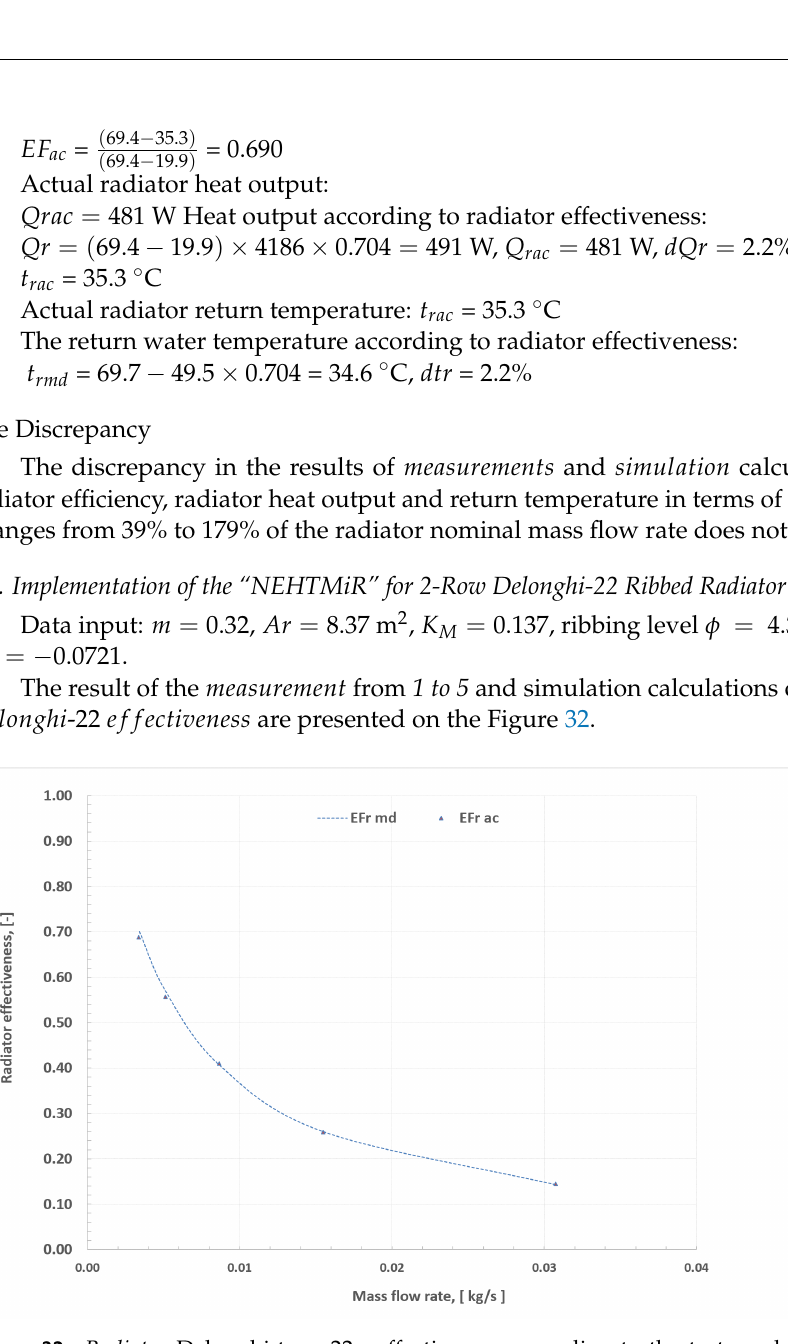
Figure 32. Radiator Delonghi-type 22—effectiveness according to the tests and simulations cal- culations by “ NEHTMiR md ” in the mass flow range m r from 20% to 150% of the nominal value. Example 6. q mx = 0.0379 kg/s, t s = 89.8 ◦ C, t i = 19.9 ◦ C, ∆ t 1 = 89.8 − 19.9 = 69.9